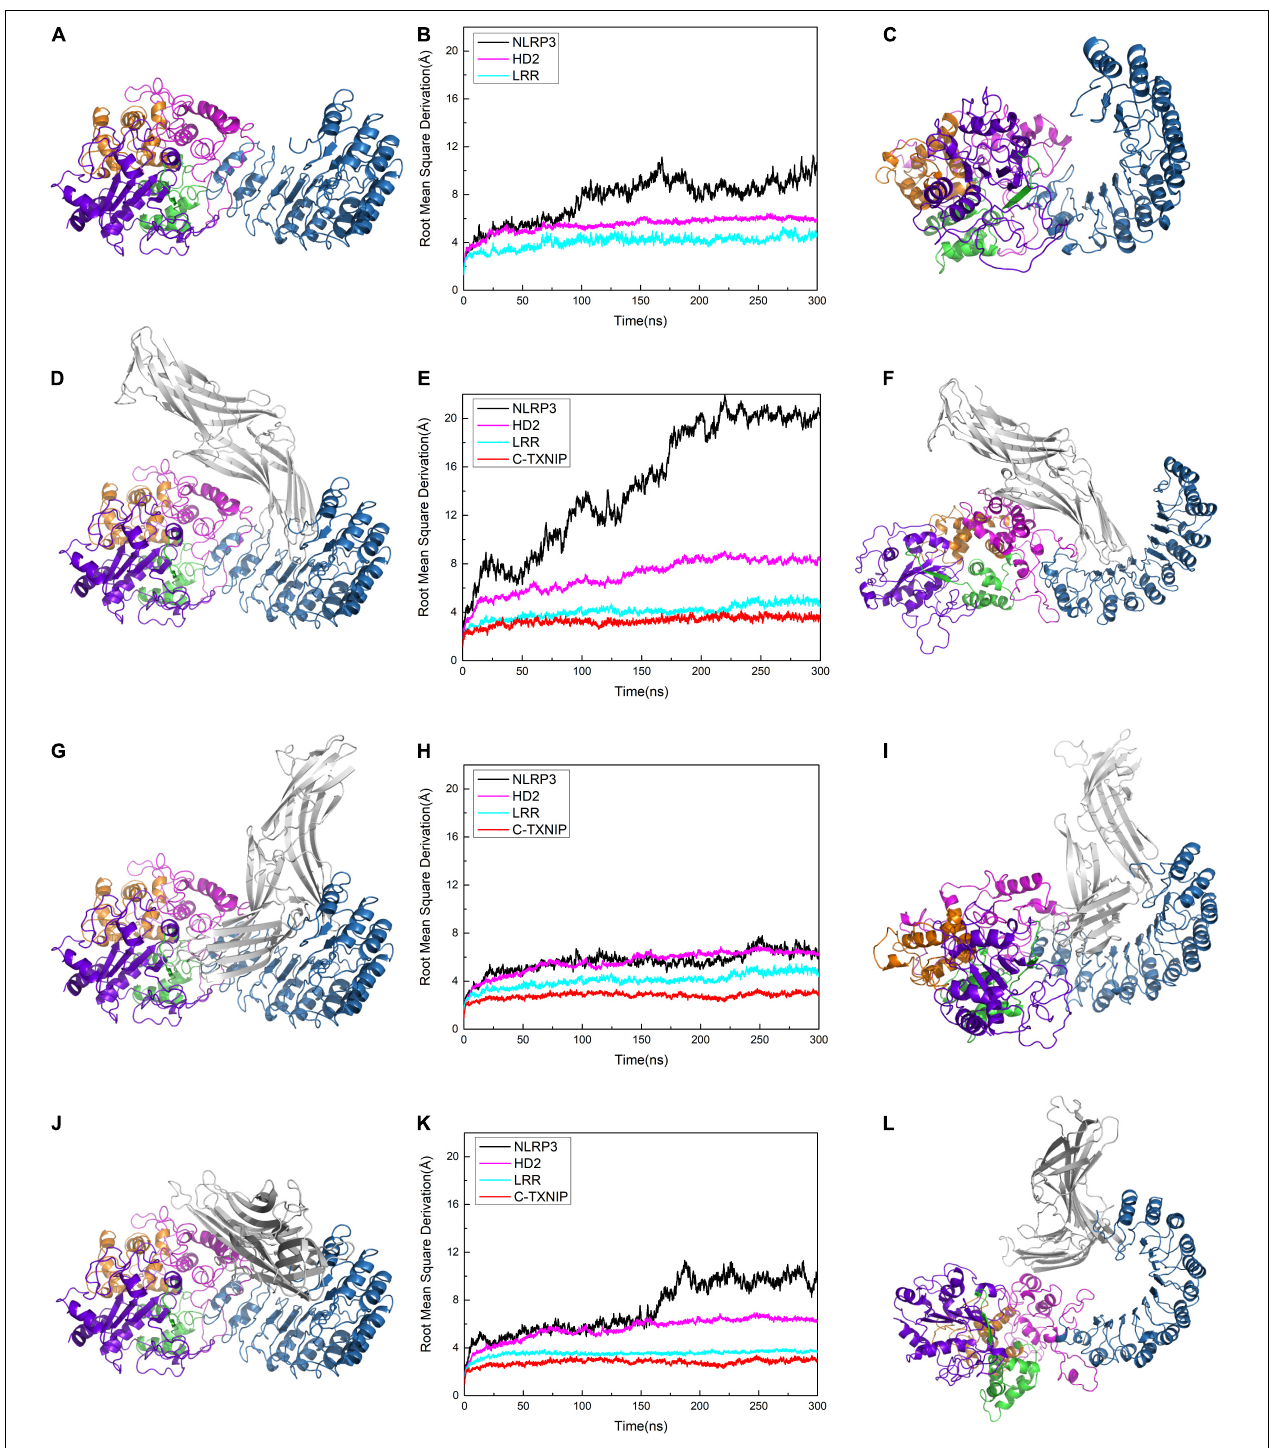
FIGURE 3 | Protein conformation of (A) NLRP3 alone. Protein conformations of the NLRP3/TXNIP complexes in (D) Model 1, (G) Model 2, and (J) Model 3. Root mean square derivation (RMSD) curves of (B) NLRP3 alone, (E) Model 1, (H) Model 2, and (K) Model 3 after simulation at 0, 50, 100, 200, 250, and 300 ns. The black, magenta, cyan, and red curves represent the RMSD curves of the overall structure of NLRP3, NLRP3/HD2, NLRP3/LRR, and NLRP3/C-TXNIP, respectively. The last frame of the trajectory of (C) NLRP3 alone, (F) Model 1, (I) Model 2, and (L) Model 3 are shown.